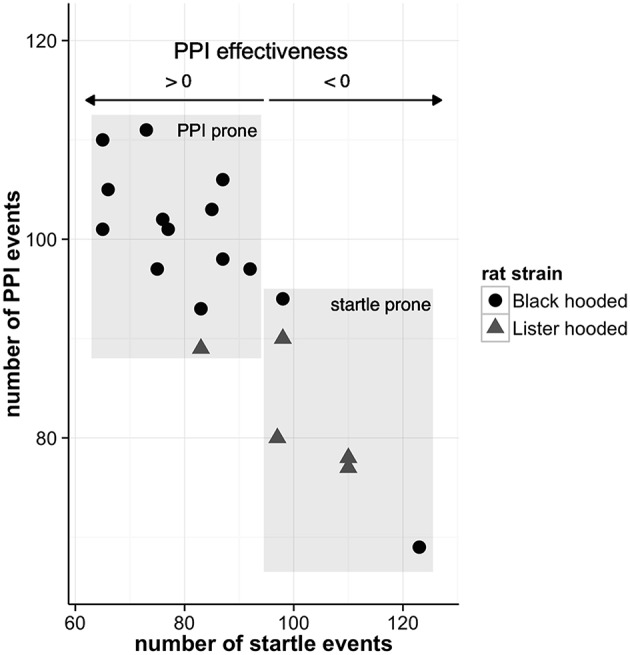
Individual PPI effectiveness. The PPI effectiveness resembles the relative difference of the number of PPI and startle events. If animals experience more PPI than startle events, PPI effectiveness is greater than zero whereas negative values signify more startle events. While most of the well-hearing Black hooded rats are more prone to PPI, the Lister hooded rats exhibit higher hearing thresholds and are prone to startle (for hearing threshold details see Rohleder et al., 2014).